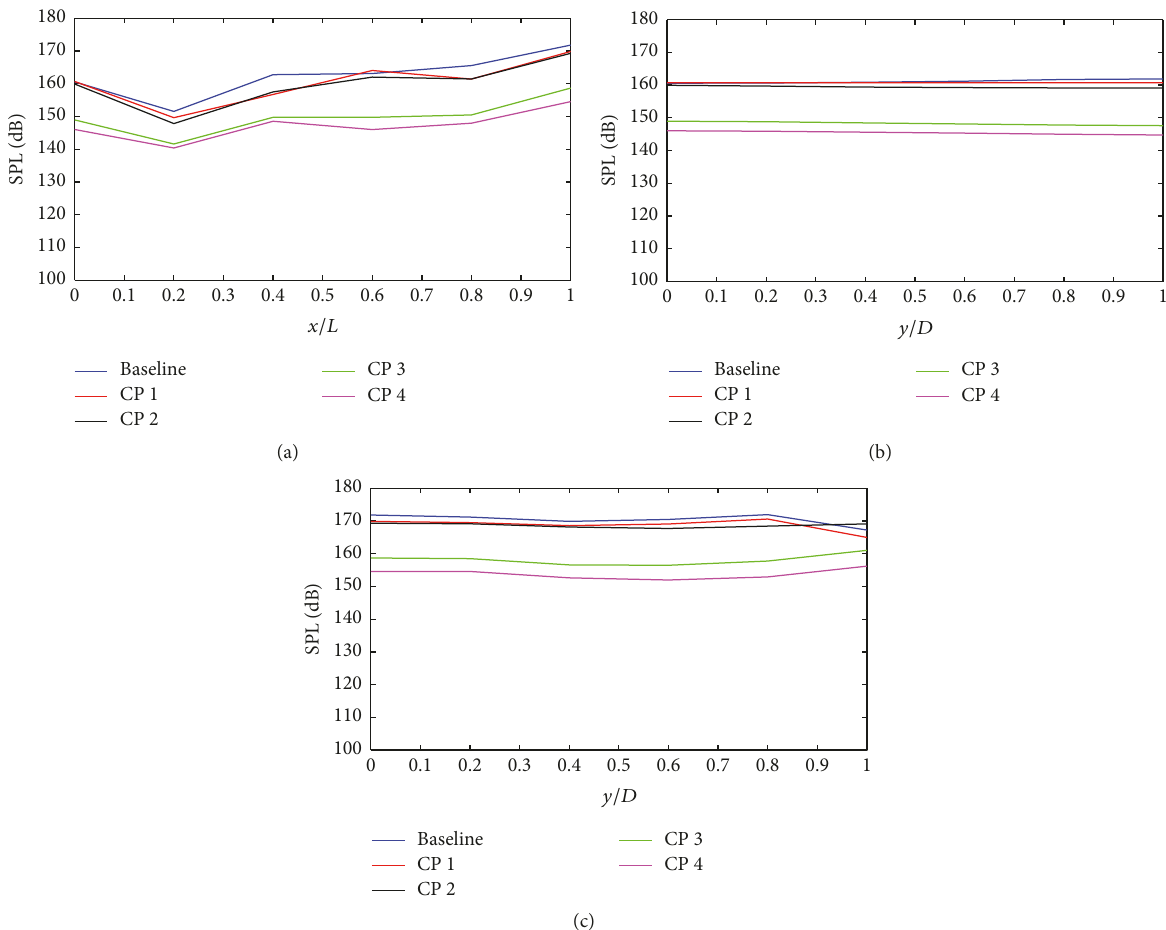
Figure 14: Sound pressure levels for cavity walls for cover plate cases. (a) Bottom wall. (b) Leading edge wall. (c) Trailing edge wall.